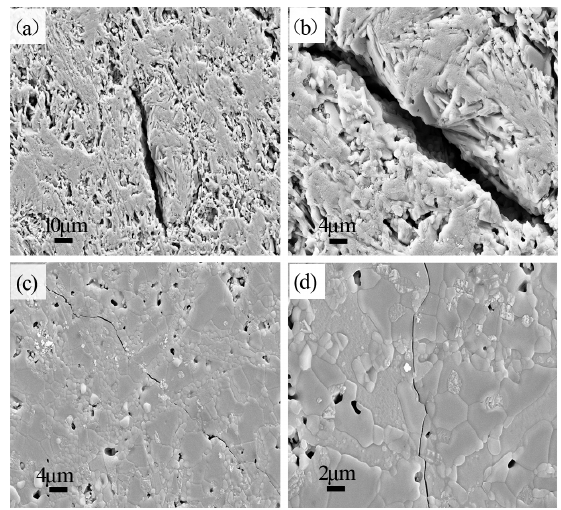
Figure 7. SEM images of the microstructures of samples with different BaO additions after thermal shock cycling. ( a ) Without BaO; ( b ) Magnification of microcracks in the sample without BaO; ( c ) 6 wt. % BaO; ( d ) Magnification of microcracks in the sample with 6 wt. % BaO.